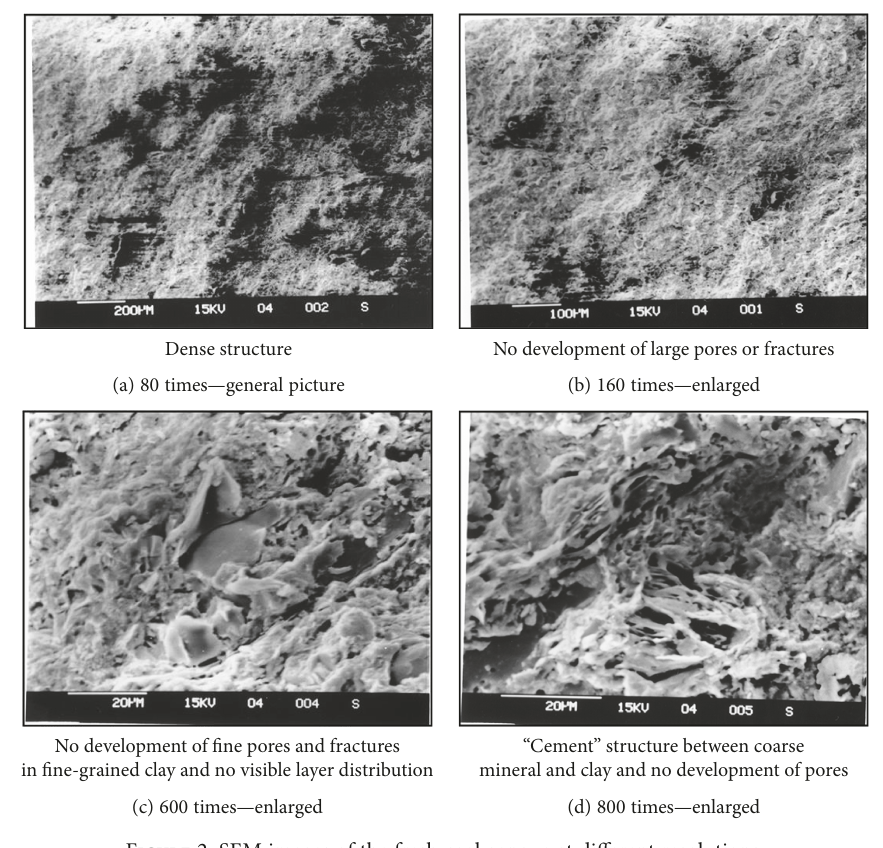
Figure 2: SEM images of the fresh coal gangue at di ff erent